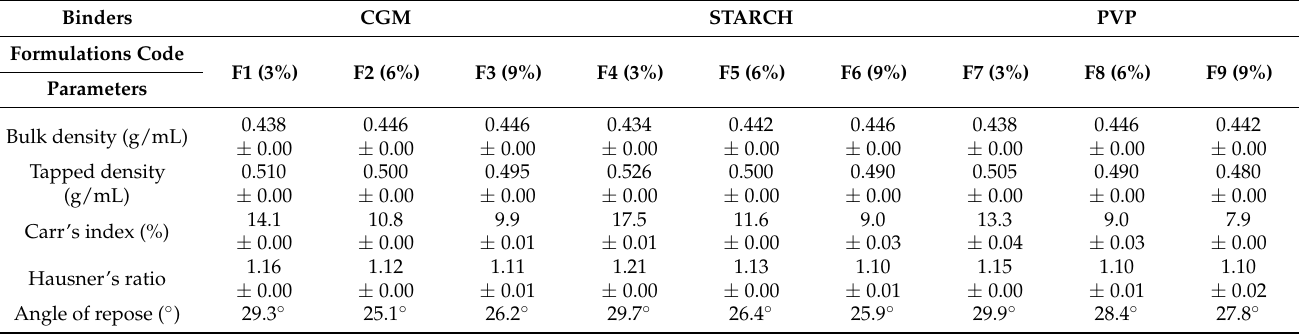
Table 7. Flow properties of formulated granules (Binding agents).